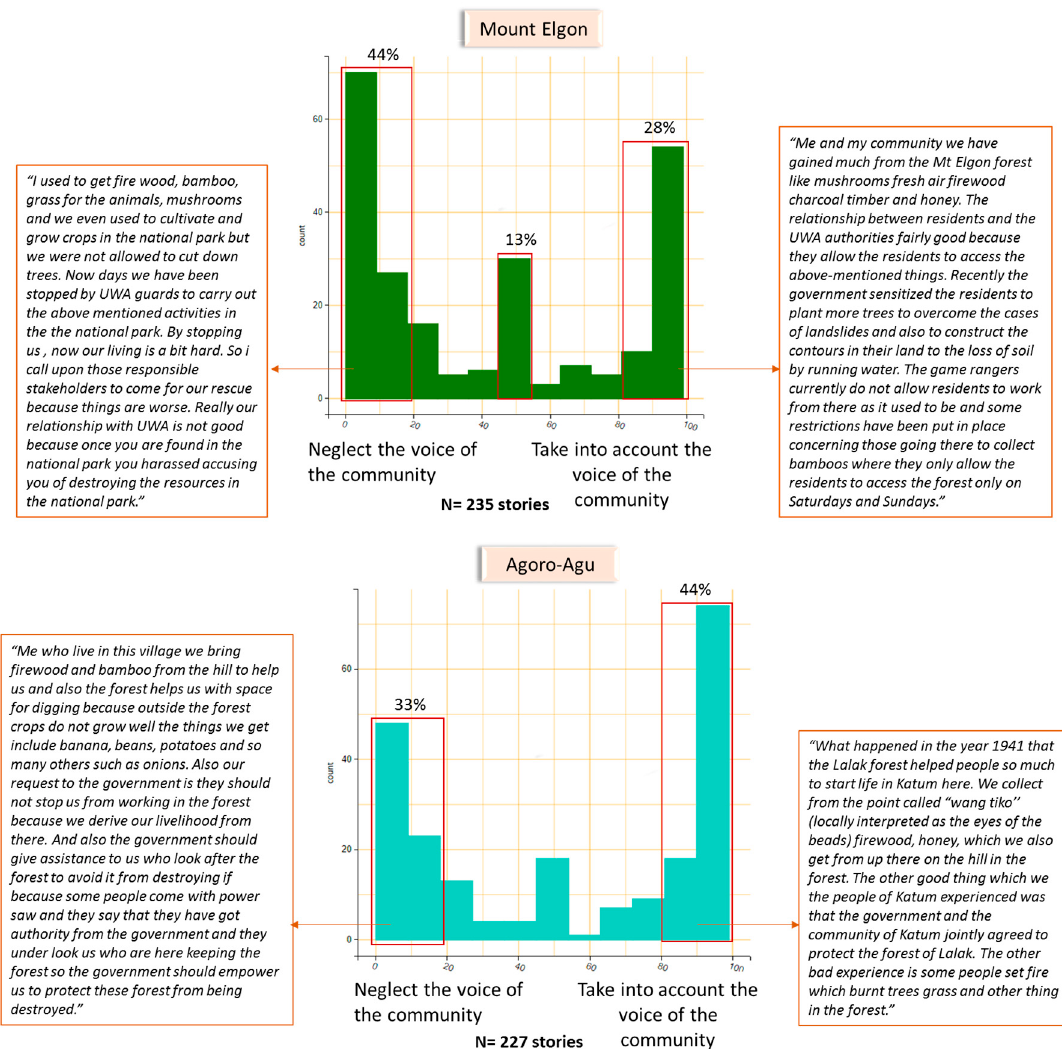
Figure 5. How the voice of the communities is taken into account in both